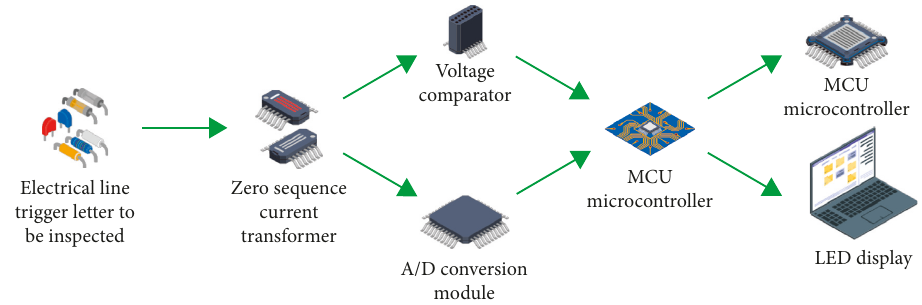
Figure 1: System structure block